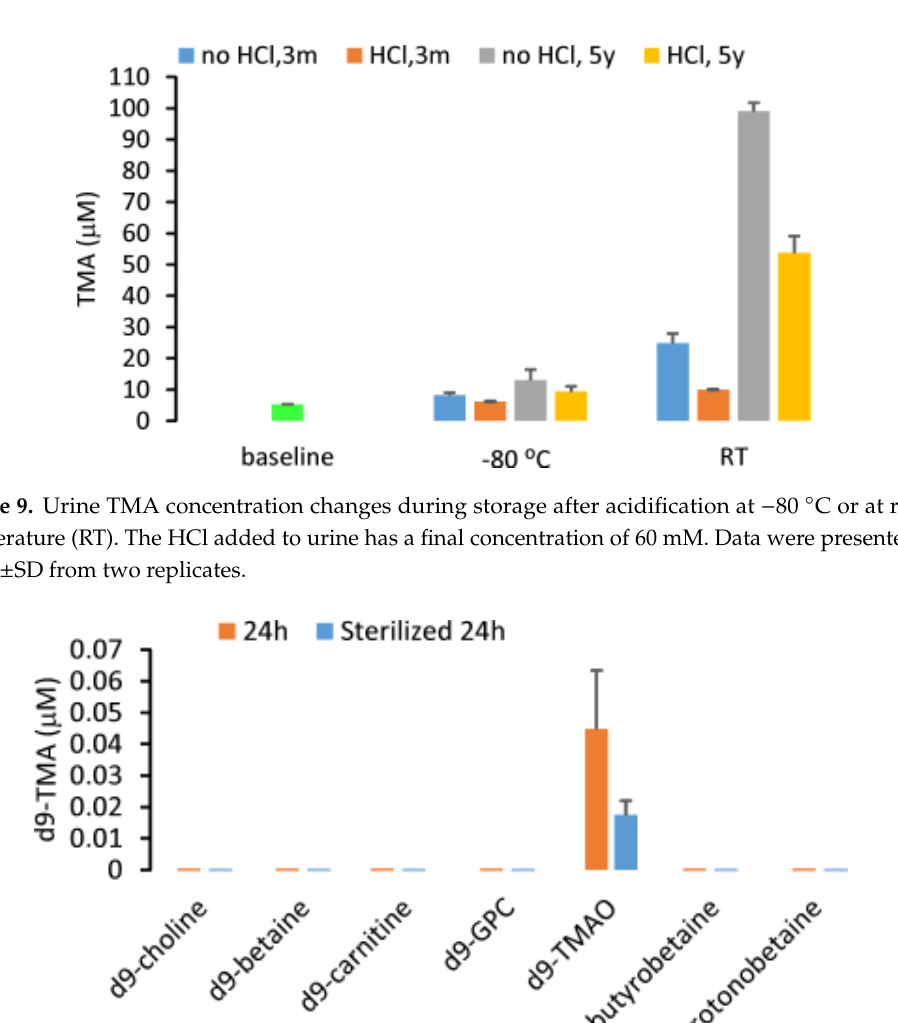
stock solution was diluted to 10 – 50 μM and calibrated with standard curves after spiking-in a fixed